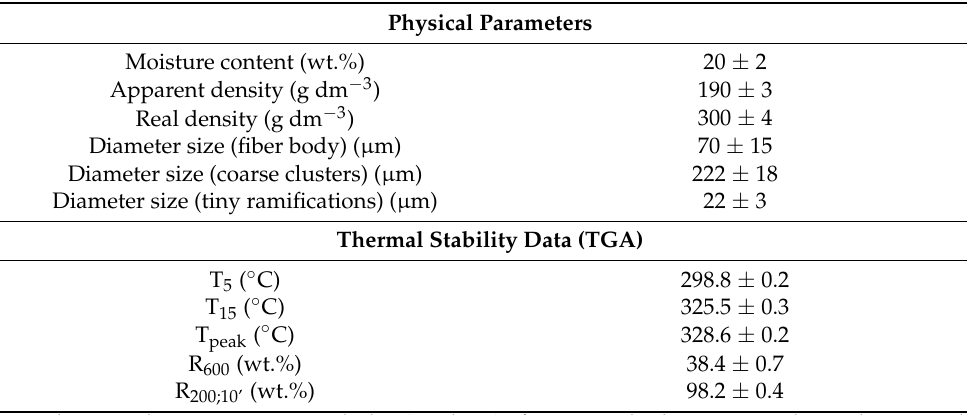
Table 1. Physical parameters and thermal stability data of WB